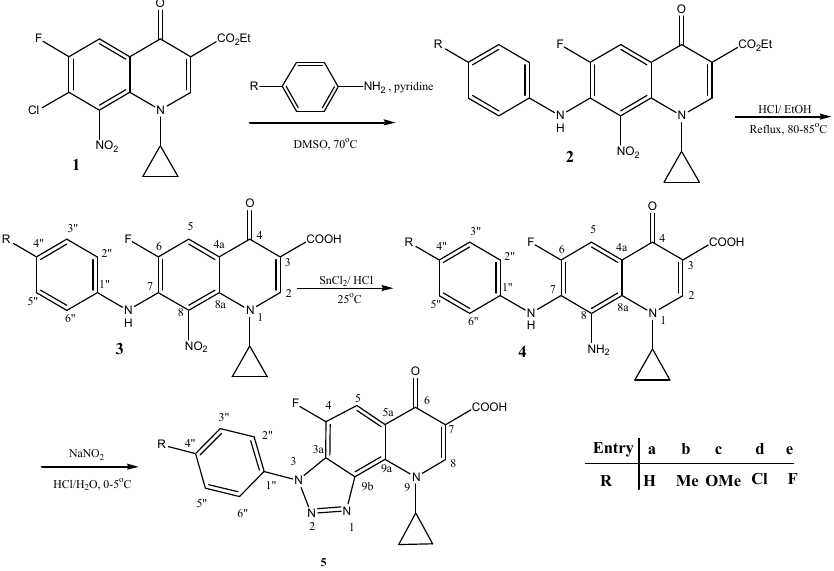
Scheme 1. General procedure for the synthesis of novel target compounds 4 , 5 ( a – e ). DMSO: dimethylsulfoxide.